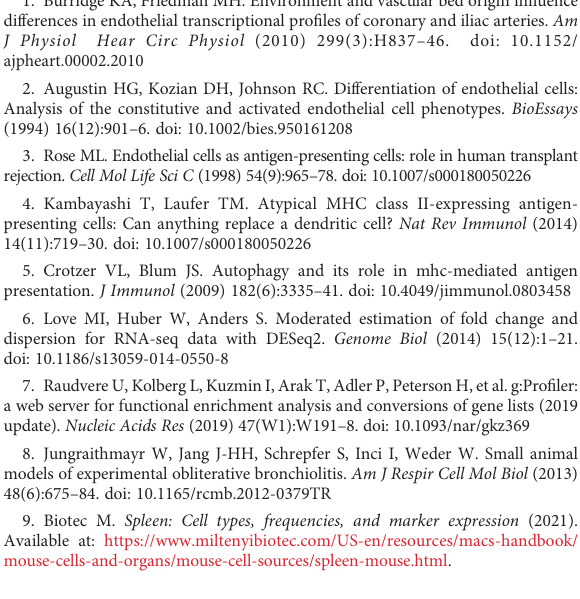
SUPPLEMENTARY FIGURE 8 Comparison of cytotoxicity, IFN g Release, and proliferation in syngeneic (LEW) and allogeneic (BN) EC-SP co-cultures. Lewis (LEW) and Brown Norway (BN)SPswereco-cultured withBNECs. (A) Co-culture withnaïve SPs did not cause increased EC death in a 3 hour co-culture. (B) Allogeneic SPs trended towards greater IFN g release compared to syngeneic SPs although the difference did not reach statistical signi fi cance. (C) Allogeneic SPs proliferated more in co-culture with ECs than alone while syngeneic SPs did not. (D) The proportion of the CD3+ cells within allogeneic co-cultures increased relative to allogeneic SPs alone and relative to syngeneic co-cultures. Statistics: two- way ANOVA. SUPPLEMENTARY FIGURE 9 IFN g releasefromSPsisolatedfromratsimplantedwith allogeneicECs – 2 days. Although not statistically signi fi cant, all EC implanted groups trended towards greater IFN g release than sham at 2 days. (B) Sham SPs showed signi fi cantly more IFN g release than EC implanted groups between 2 and 4 days of in vitro culture. Compared to the sham group, implanted rats had a non-signi fi cant increase in IFN g release at 2 days. Statistics: Ordinary one-way ANOVA. n=6. SUPPLEMENTARY FIGURE 10 Proliferation in SPs isolated from rats implanted with allogeneic ECs – 2 days. MFI, mean fl uorescence intensity. 3DSF SPs showed greater proliferation than 2Df and 3Df SPs in both the acute and chronic groups, after 2 days of co-culture. Nearly all proliferation appears to have occurred in the fi rst two days of in vitro culture. Statistics: Ordinary one-way ANOVA. n=6.